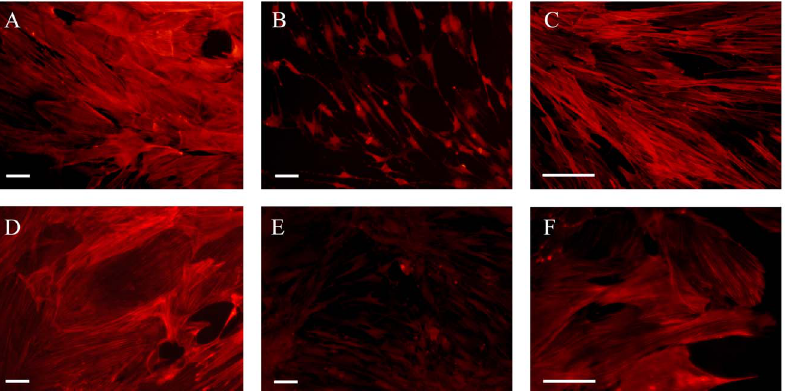
Figure 9. Effects of H 2 O 2 and Zn 2 + on actin reorganization in adult astrocyte cultures. The culture medium was removed, followed by the addition of DMEM/F12 supplemented with 5% FBS, and the cells were maintained at 5% CO 2 (37 u C) in the presence or absence of H 2 O 2 or Zn 2 + for 3 h. Representative images of the rhodamine-phalloidin fluorescence signals of cells exposed to ( A, D ) basal conditions, ( B ) 50 m M H 2 O 2 , ( C ) H 2 O 2 + SB203580 (5 m M), ( E ) 50 m M Zn 2 + and ( F ) Zn 2 + + LPA (2 m M). All images are representative fields from at least 3 experiments performed in duplicate. Scale bars: (A, B, D, E)=50 m m, (C, F)=100 m m.